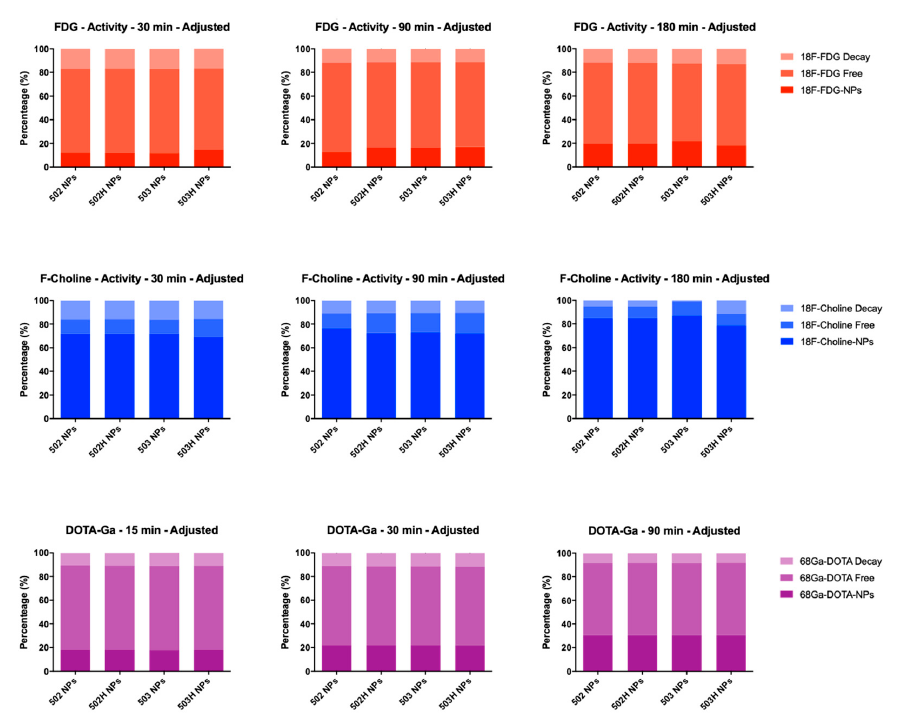
Figure 16. 18 F-Choline ( top ), 18 F-FDG ( middle ) and 68 Ga-DOTA ( bottom ) radiolabeling stability and efficiency for PLGA-based nanoparticles over time.